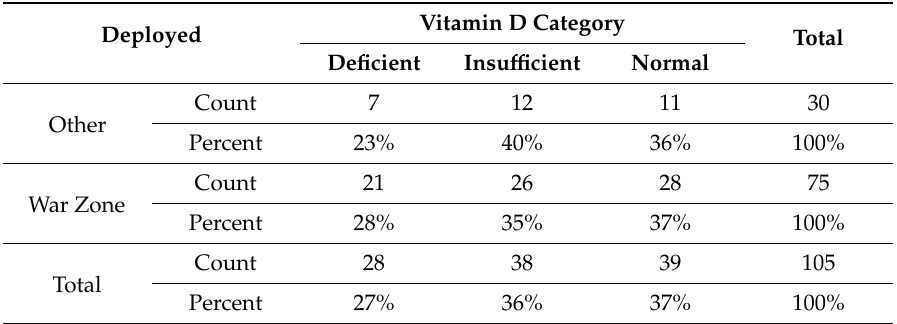
Table 2. Distribution of U.S. Marines across vitamin D categories. No difference in distribution by